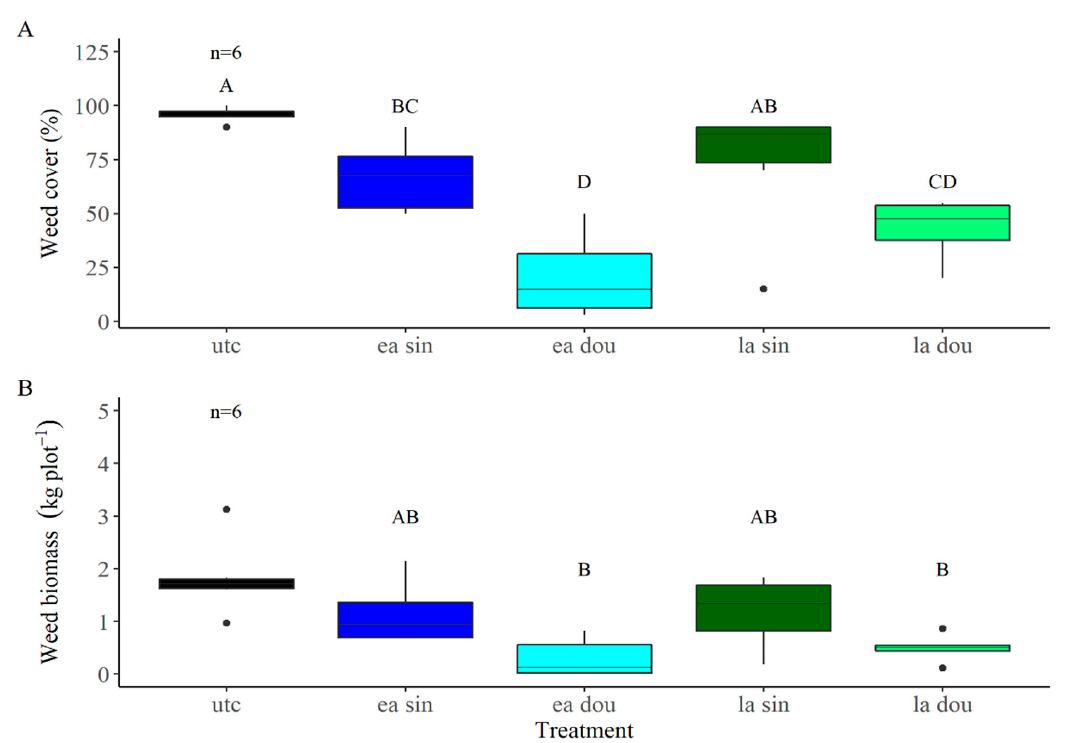
Figure 5. Effect of finger weeder treatments on weed control efficacy. ( A ) Weed cover and ( B ) biomass in the 2020 season. The treatments included: untreated control (utc), early single (ea sin), early double (ea dou), late single (la sin), and late double (la dou). Different letters indicate a significant difference between treatments according to the Tukey-HSD test ( n = 6).